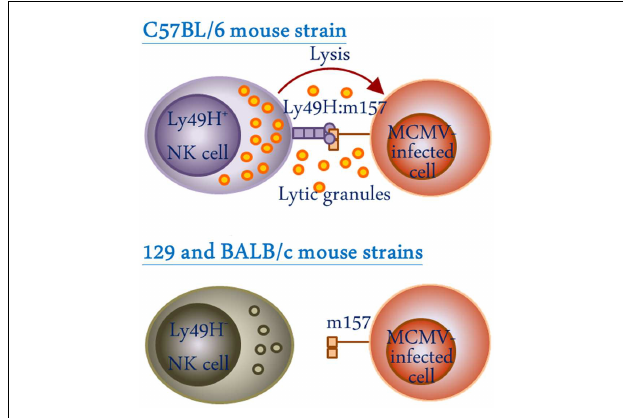
FIGURE 3 | Schematic representation of the role of the activating Ly49H receptors in recognition of MCMV-infected cells . NK cells from C57BL/6 but not 129 or BALB/c mouse strains express Ly49H and are capable of recognizing m157 viral protein on the surface of MCMV-infected cells, thereby, conferring resistance against MCMV